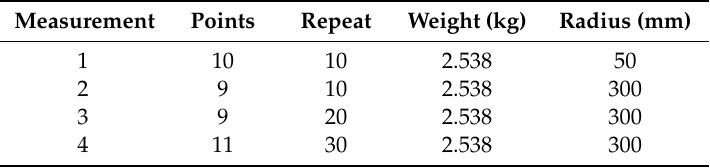
Table 4. Parameters for measurements of the influence of the number of